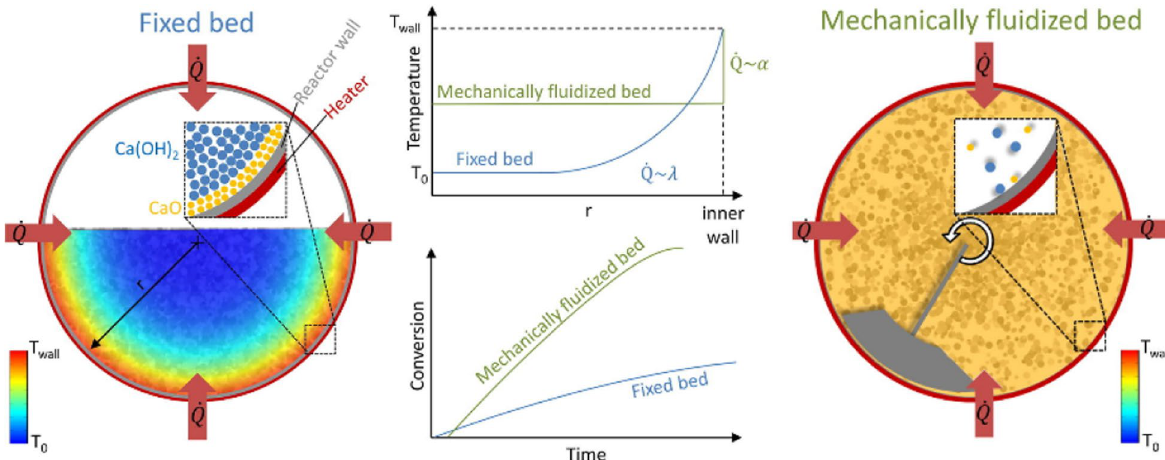
Fig. 9 The novel reactor concept based on a plow share mixer for fluidization of CaO/Ca(OH) 2 system